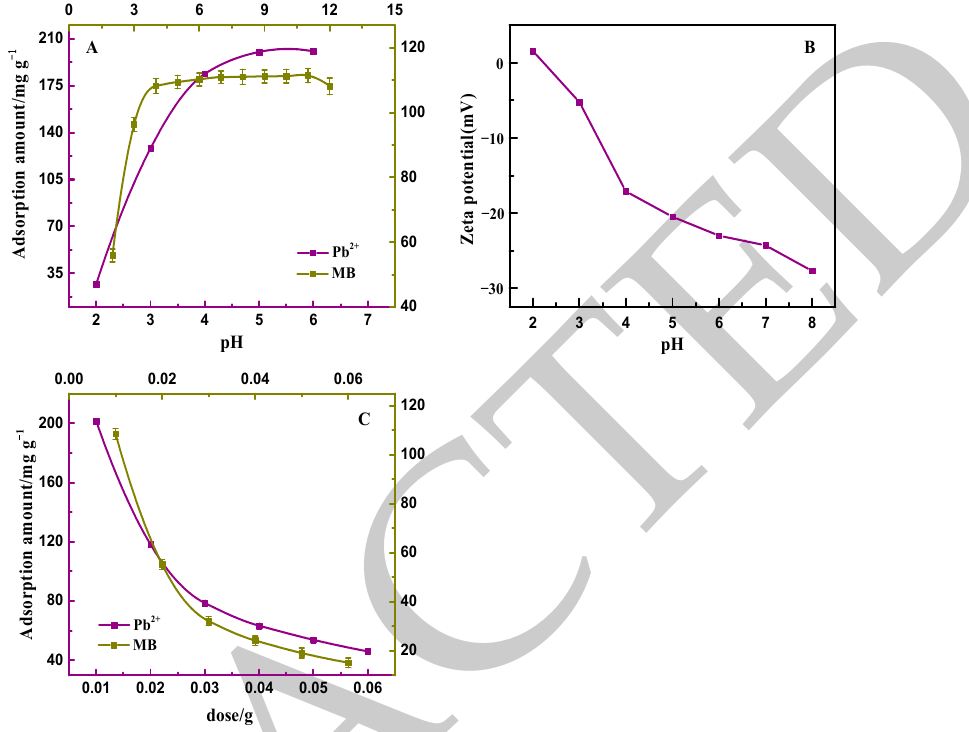
Figure 3. The effect of pH on PAA/LS/BC adsorption of Pb 2+ and MB ( A ); the zeta potential of PAA/LS/BC at different pH ( B ); the effect of adsorbent dose on PAA/LS/BC adsorption of Pb 2+ and MB ( C ).